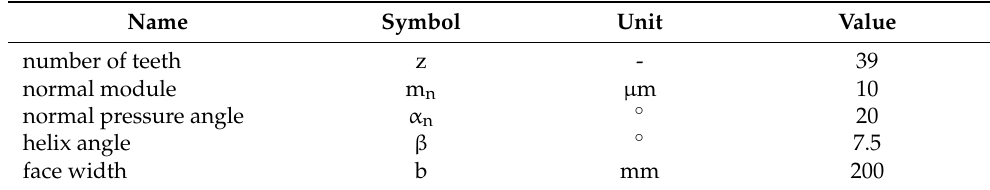
Table 2. Specifications of the test